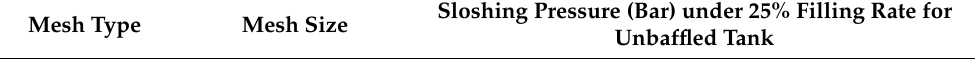
Figure 7. Comparison of sloshing pressure effect between unbaffled and baffled rectangular tanks with perforated and imperforate baffles under 25% filling ratio. Table 3. Comparison of mesh sensitivity study.